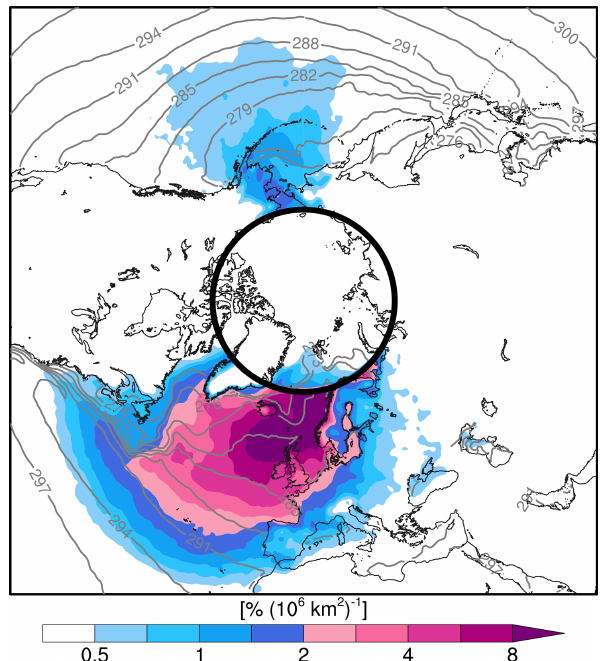
Figure 3. Moisture uptake per area for all moist-air intrusions in percent of the total moisture transported across 70 ◦ N by the trajec- tories. Gray contours show SST in intervals of